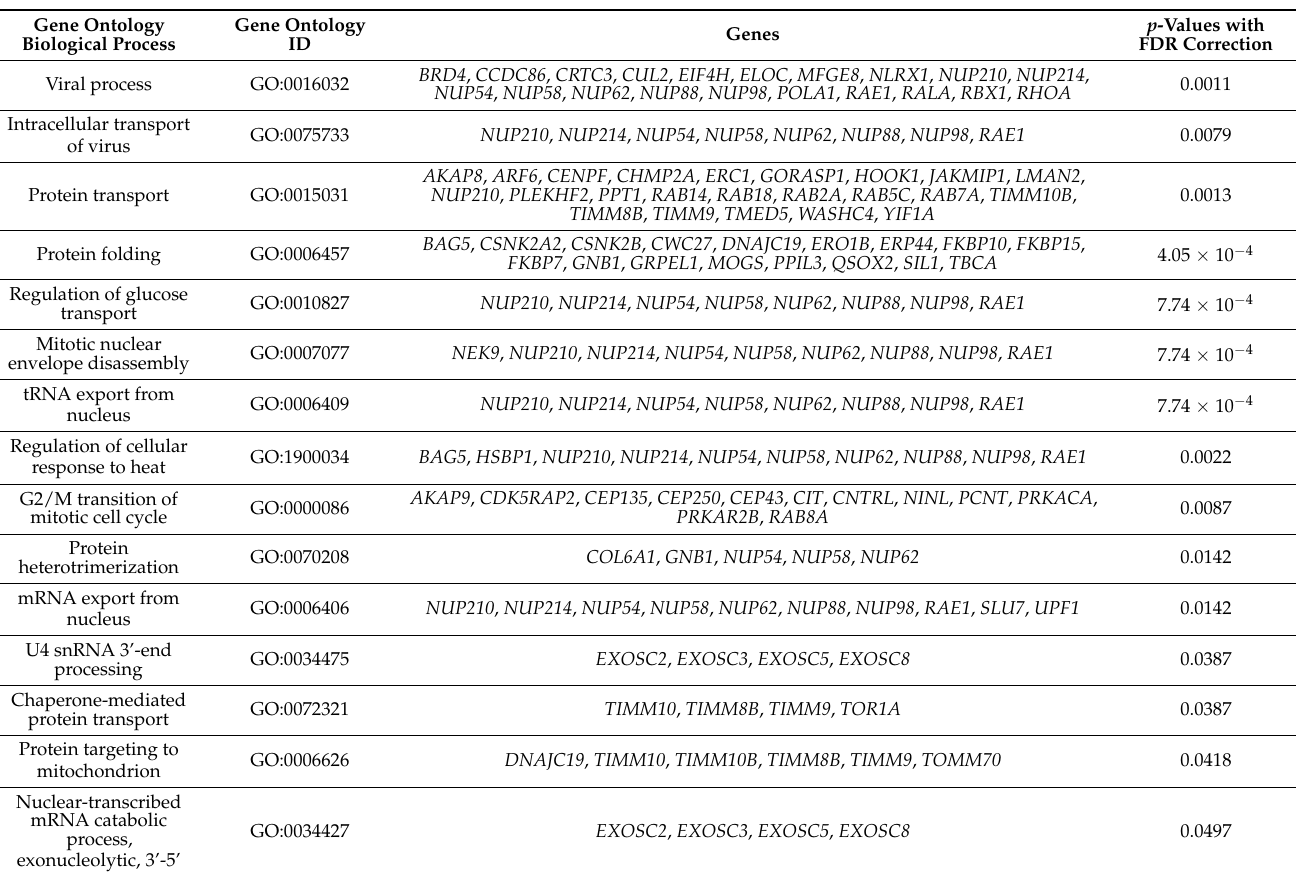
Table 10. Overrepresented GO biological processes for SARS-CoV-2-targeted human proteins found by DAVID ( p -values < 0.05 with FDR